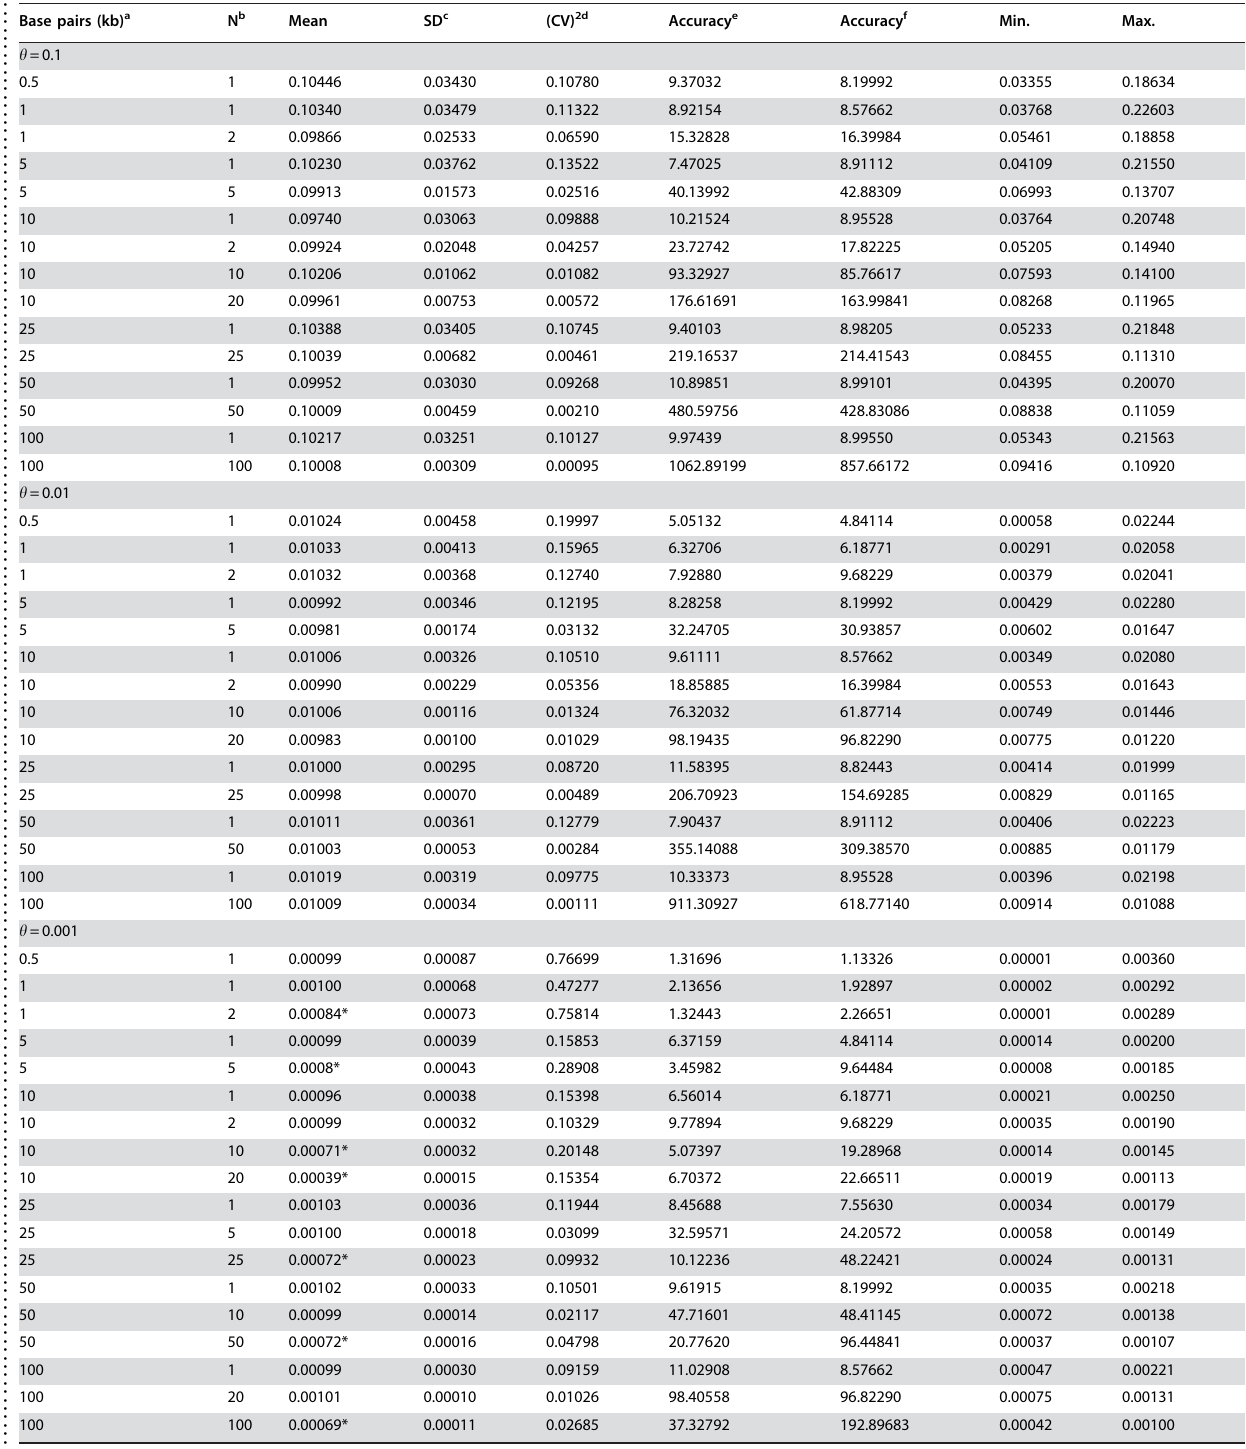
Table 1. Simulation conditions and summary statistics for e` calculations. .. ... .... ... ... .... ... ... .... ... ... .... ... ... .... ... ... .... ... ... .... ... ... .... ... ... .... ... ... .... ... ... .... ... ... .... ... ... .... ... ... .... ... ...